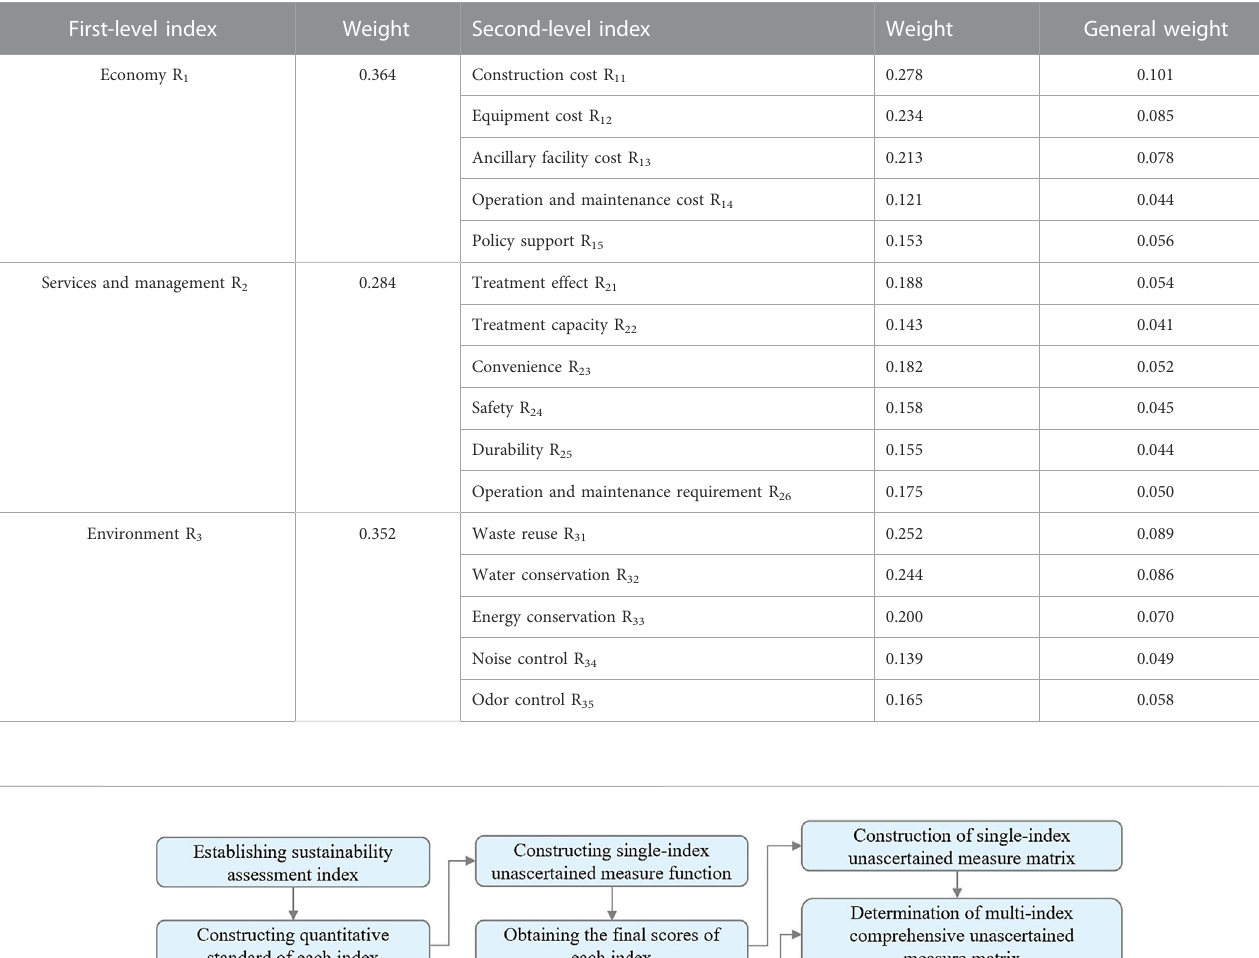
TABLE 2 Weights of sustainability assessment indexes.